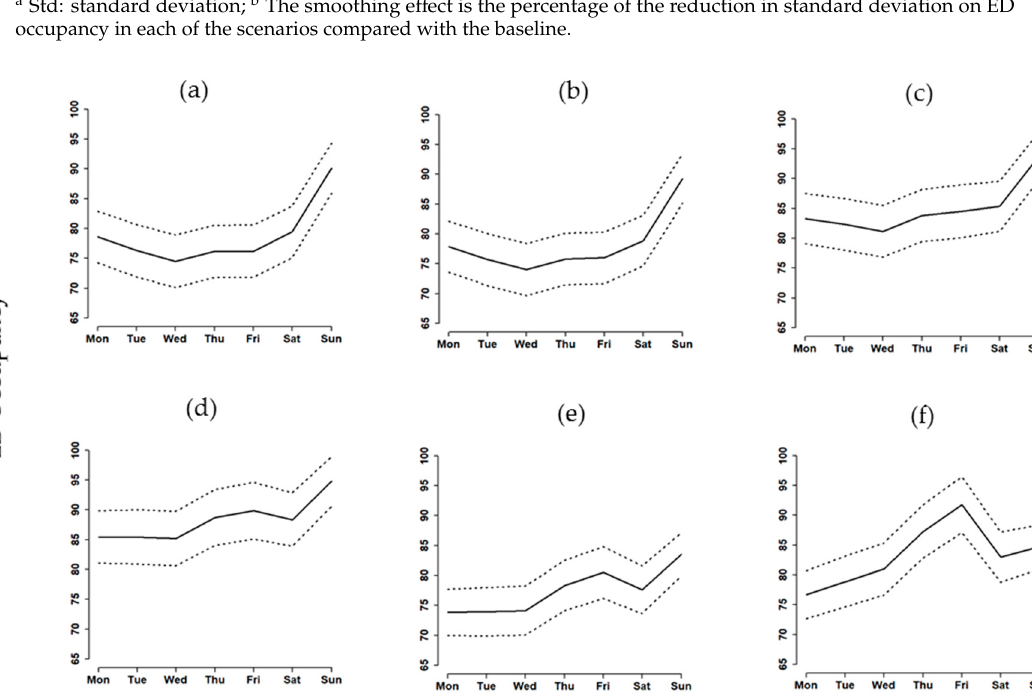
Figure 3. The mean and 95% CI of ED occupancy under different scenarios: (a) S1 (average), (b) S2 (– 5%), (c) S3 (–10%), (d) S4 (–15%), (e) S5 (–20%), and (f) S6 (–30%).